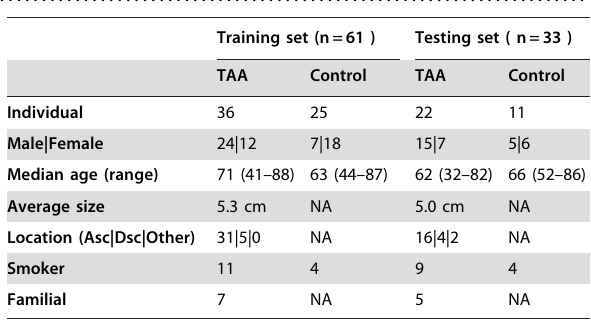
Table 1. Summary of clinical characteristics of 94 TAA